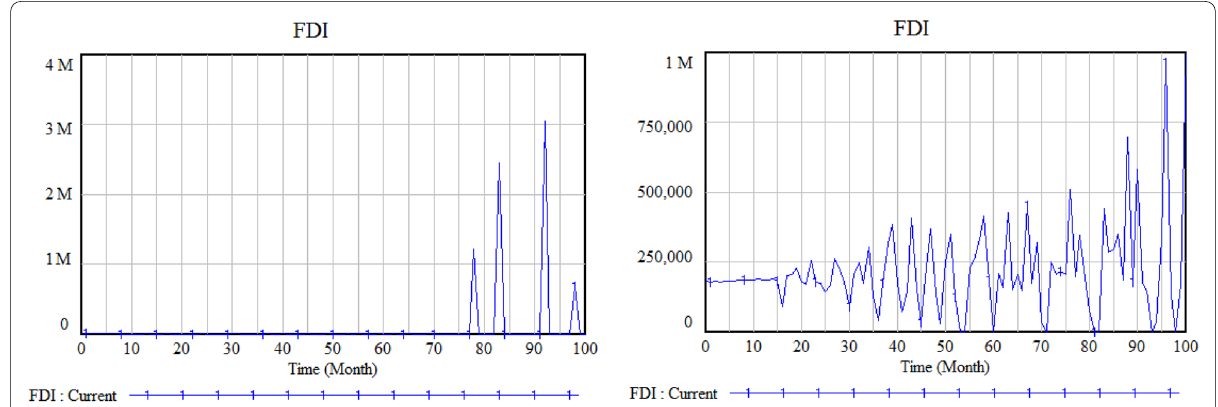
Fig. 8 Changes in FDI in the worst case (left) and best case (right) of force majeure factor